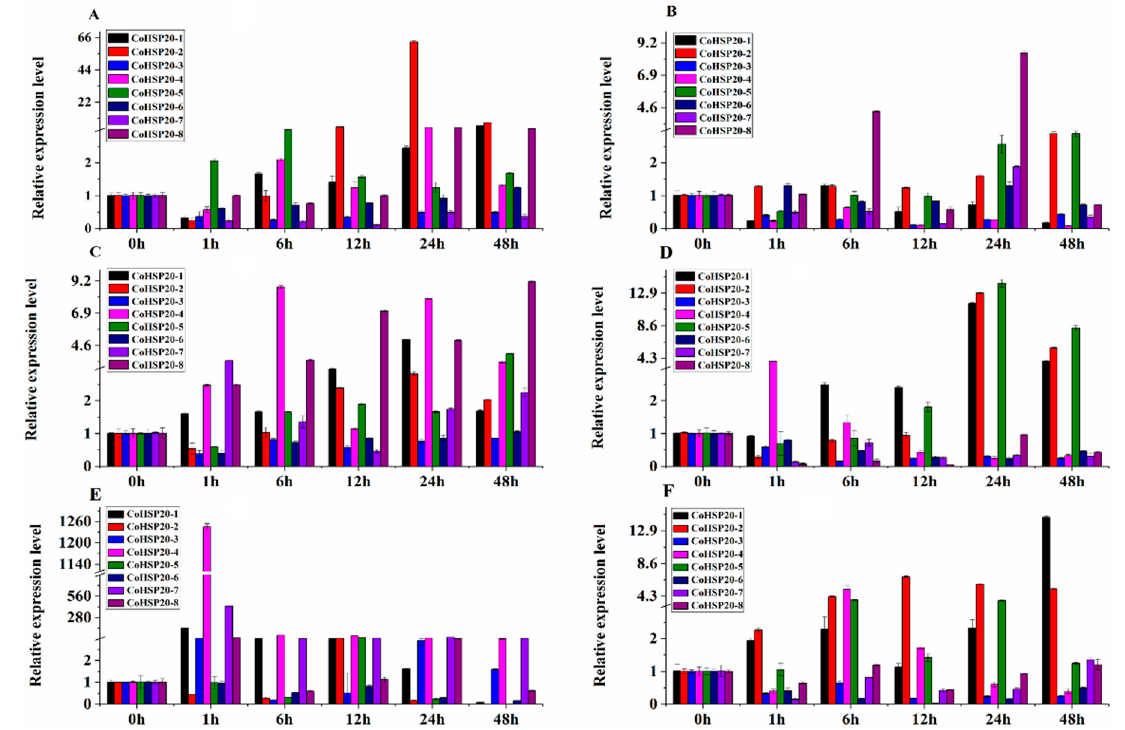
Figure 11. The relative expression level of various Co Hsp20 genes under heat ( A ), salt ( B ), drought ( C ), cold ( D ), ABA ( E ), and MeJA ( F ) treatment.